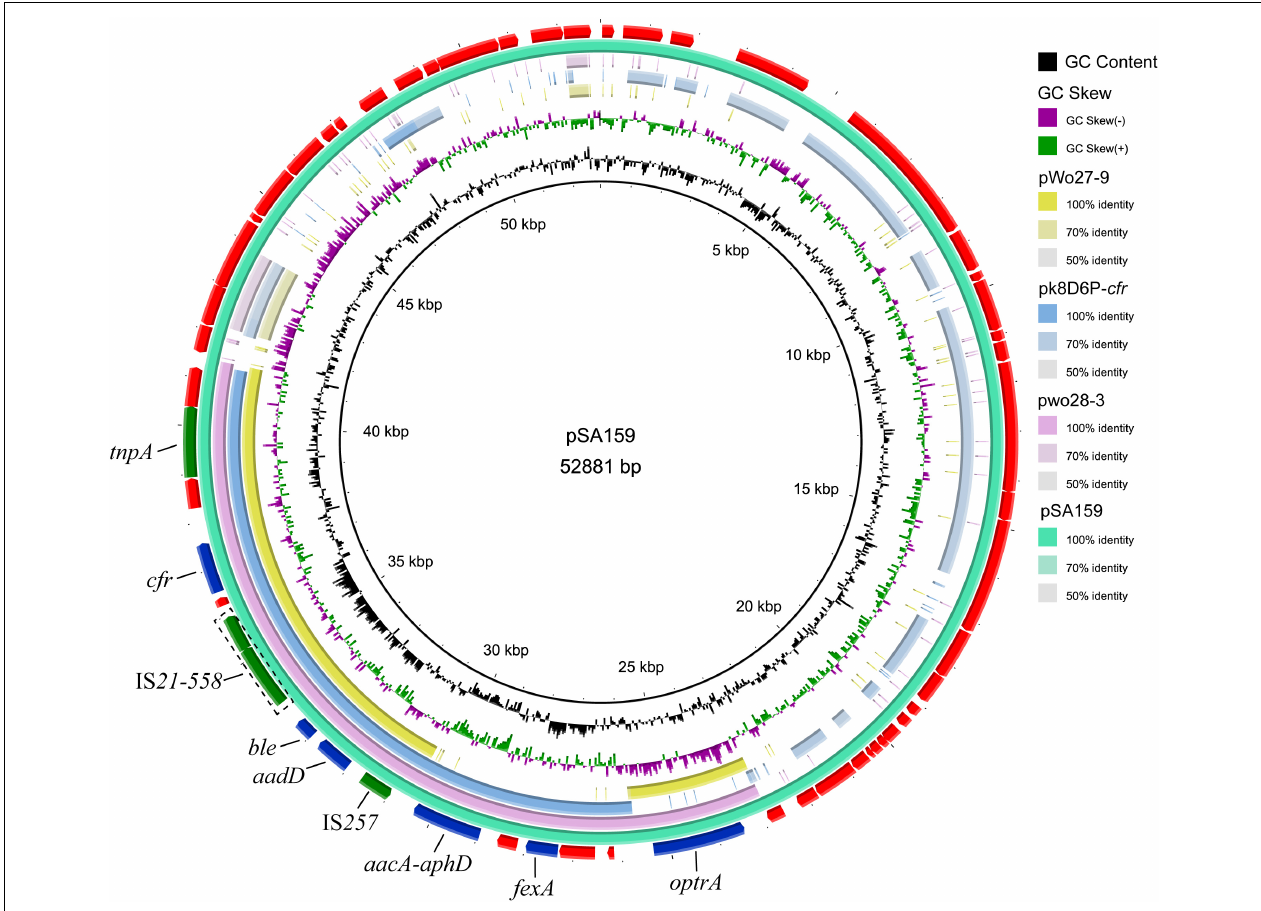
FIGURE 4 | Ring comparison of plasmid pSA159 (GD4SA159) using BRIG. Arrows indicate the positions and directions of gene transcription. Blue and green arrows indicate resistance genes and mobile genetic elements (MGEs), respectively. Genes encoding hypothetical proteins and proteins for plasmid stability are depicted in